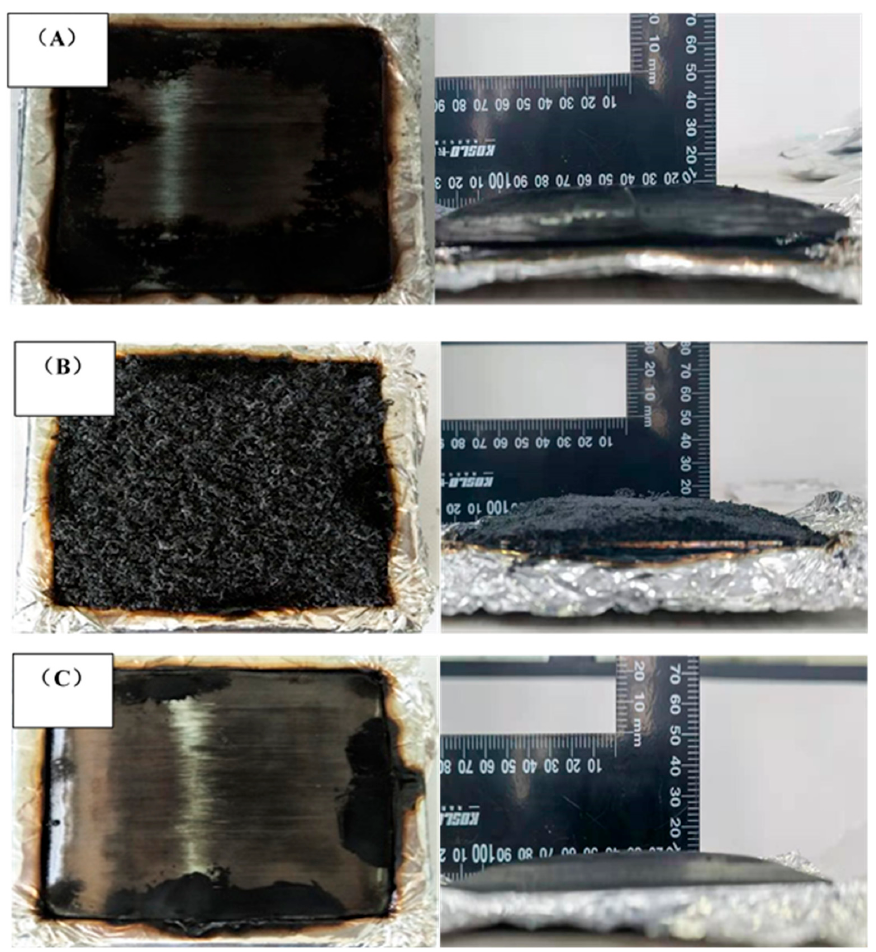
Figure 6. Images after cone calorimeter test: ( A ) Laminate 1; ( B ) Laminate 2; ( C ) Laminate 3.